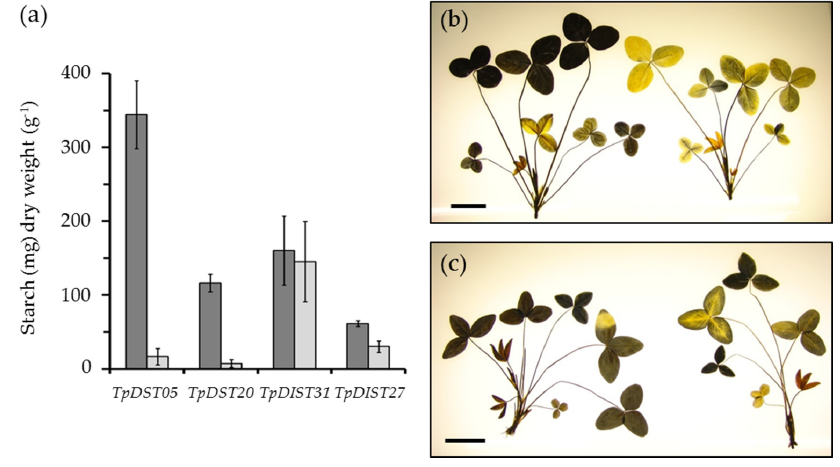
Figure 3. Diel patterns of leaf starch accumulation in selected red clover genotypes. ( a ) The starch concentration in four genotypes harvested at the end of the day (ED; dark ‐ gray bars), and at the end of the night (EN; light ‐ gray bars). Plants were grown at a fluence rate of 250–350 μ mol ∙ m 2 ∙ s − 1 in a 14:10 light/dark and 14–16 °C/19–23 °C diel cycle. Error bars indicate 95% confidence intervals ( N = 8); ( b , c ) Iodine staining of ED (left) and EN (right) plants of genotypes TpDST05 (b) and TpDIST31 (c). Details are described in Supplementary Methods.